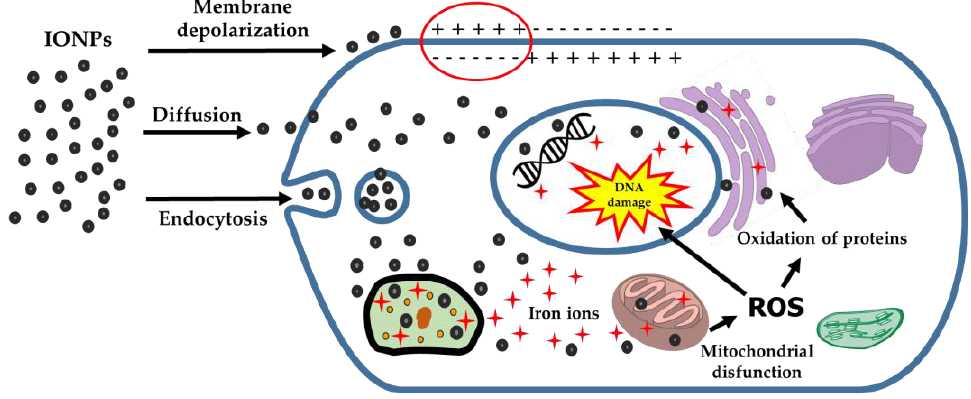
Figure 3. Main mechanisms of action by which systems based on iron oxide nanoparticles (IONPs) generate cell toxicity. ROS: reactive oxygen